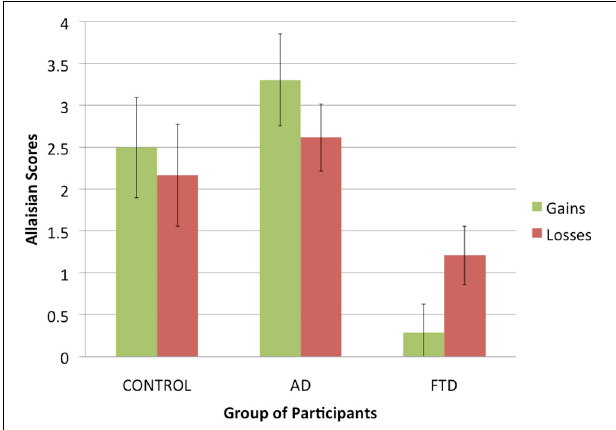
FIGURE 3 | Number of risky investments in the experimental trials of the Allais task in function of group of participants and condition (error bars indicate standard